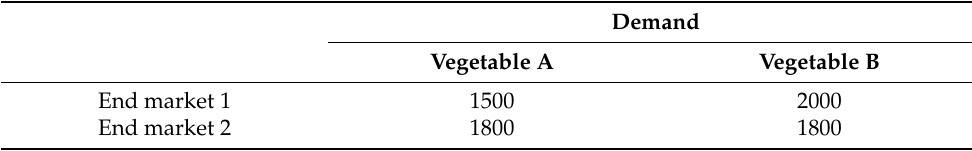
Table 2. Demand for vegetables.